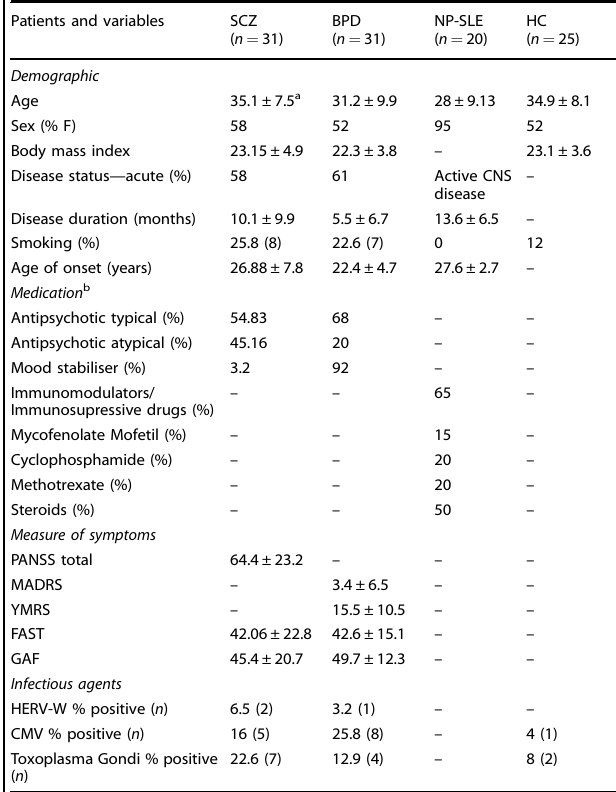
of total IgG Abs directly from the serum, in a single-step (Fig. 1). The SDS-PAGE analysis (Fig. 2a) under non-reducing conditions fractions (Fig. 1, label E). As expected, under reducing conditions (Fig. 2b) two bands corresponding to heavy (50 KDa) and light chains (25 KDa) of IgG Abs were prominent. Under similar conditions the therapeutic intravenous immunoglobulin (IVIg) was also subjected to puri fi cation. Overall, the antibody preparation was found to be homogenous and was used for further analysis.